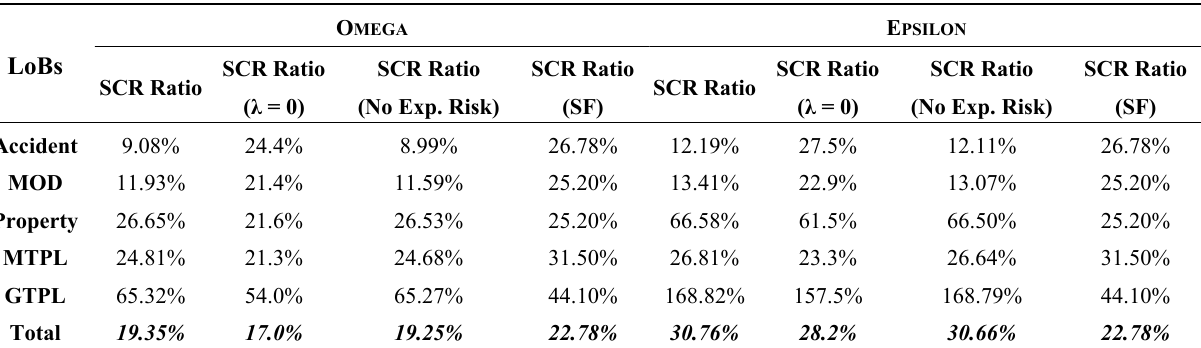
) (Gross of Reinsurance). 𝐵 𝑡